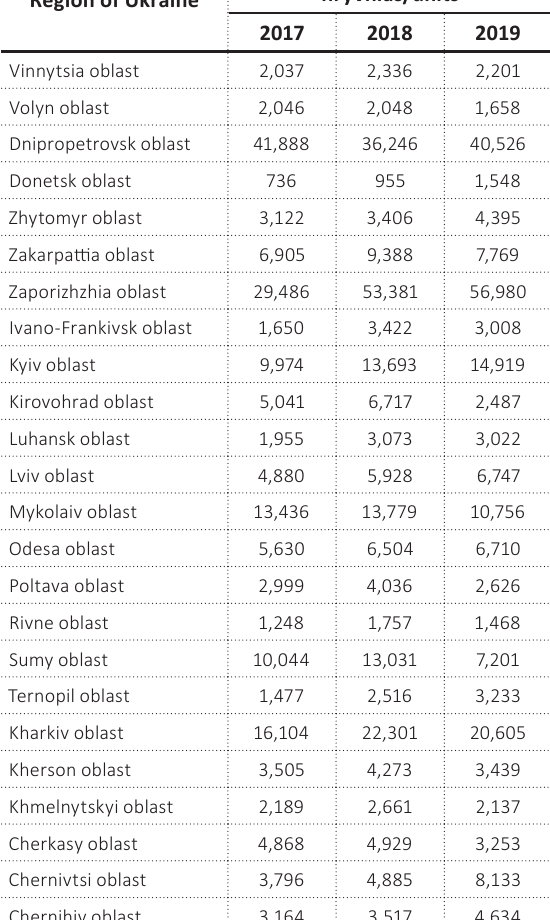
Table 5. Average values of indicators I S and for them, the values of indicators C by regions of Ukraine,